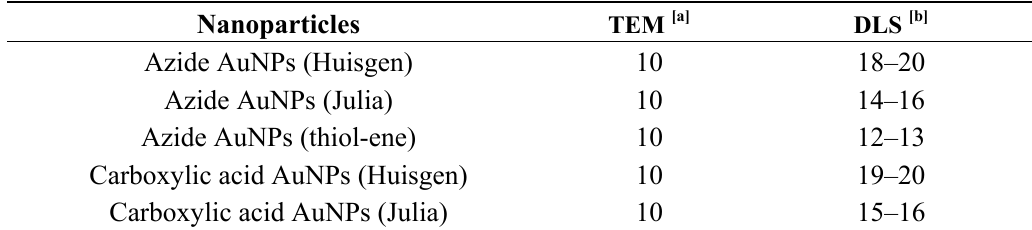
Table 2. Size of the nanoparticles in nm.